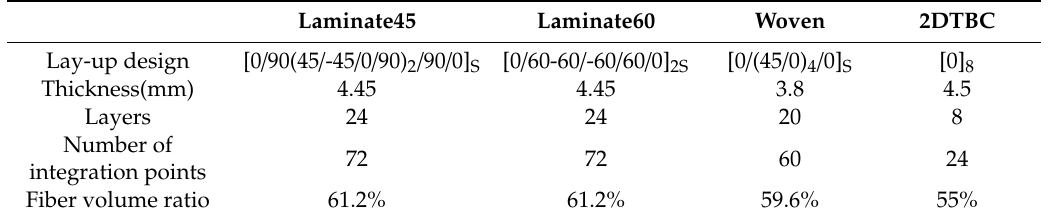
Figure 1. Scheme of architecture features and specimen images for laminate ( a ), woven ( b ) and 2DTBC [21] ( c ) composites. Table 1. Geometry and layup information of the studied composite panel specimens.